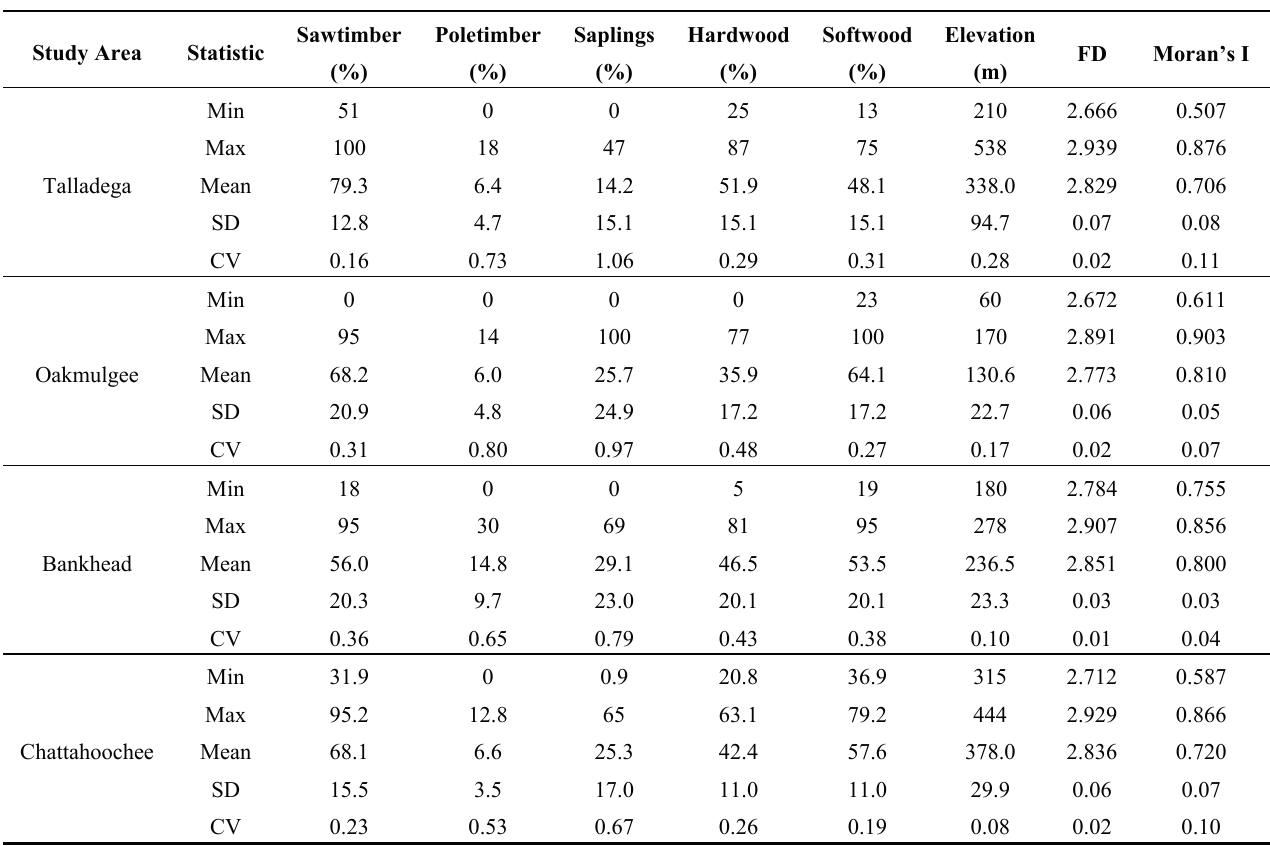
Table 2. Summary statistics of all in situ and computed variables for each study area. Study Area